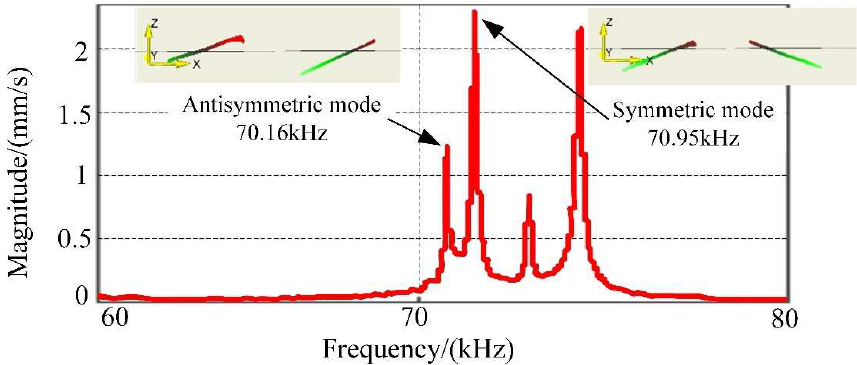
Figure 13. The frequency response curve of the stator.